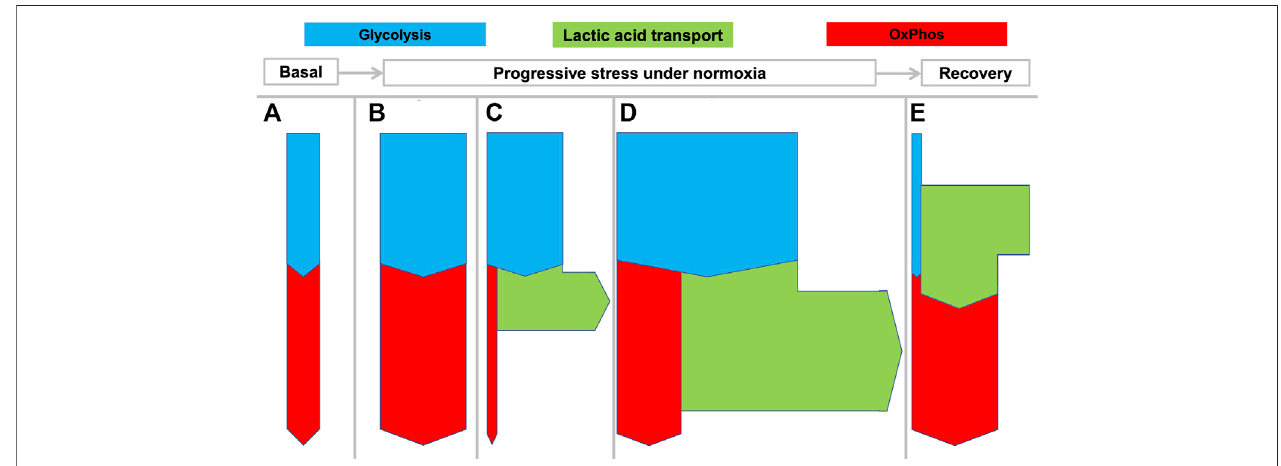
FIGURE 2 | Flexible coupling of glycolysis and OxPhos in various states in mammals. Rates of net transport are indicated by the thickness of the arrows during various states as they can develop from rest to increasing stress levels and then recovery: (A) basal metabolism; (B) enhanced aerobic metabolism with matched glycolysis and OxPhos; (C) increased “ anaerobic ” glycolysis with increased lactic acid production; (D) increased aerobic and anaerobic metabolism as can be seen in muscle during maximal work, for example during a fi ght-or- fl ight response. “ Aerobic glycolysis ” is a common metabolic phenomenon that can be intermittently displayedbymanytissuesdifferentfrommuscletomeetspeci fi crequirements.State (E) showsthatduringrecovery,excesslactatecanbeoxidizedbythesameorother tissues.